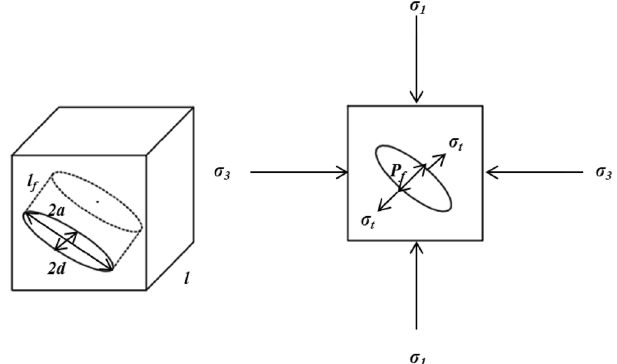
Figure 7. Freeze–thaw damage physical and mechanical